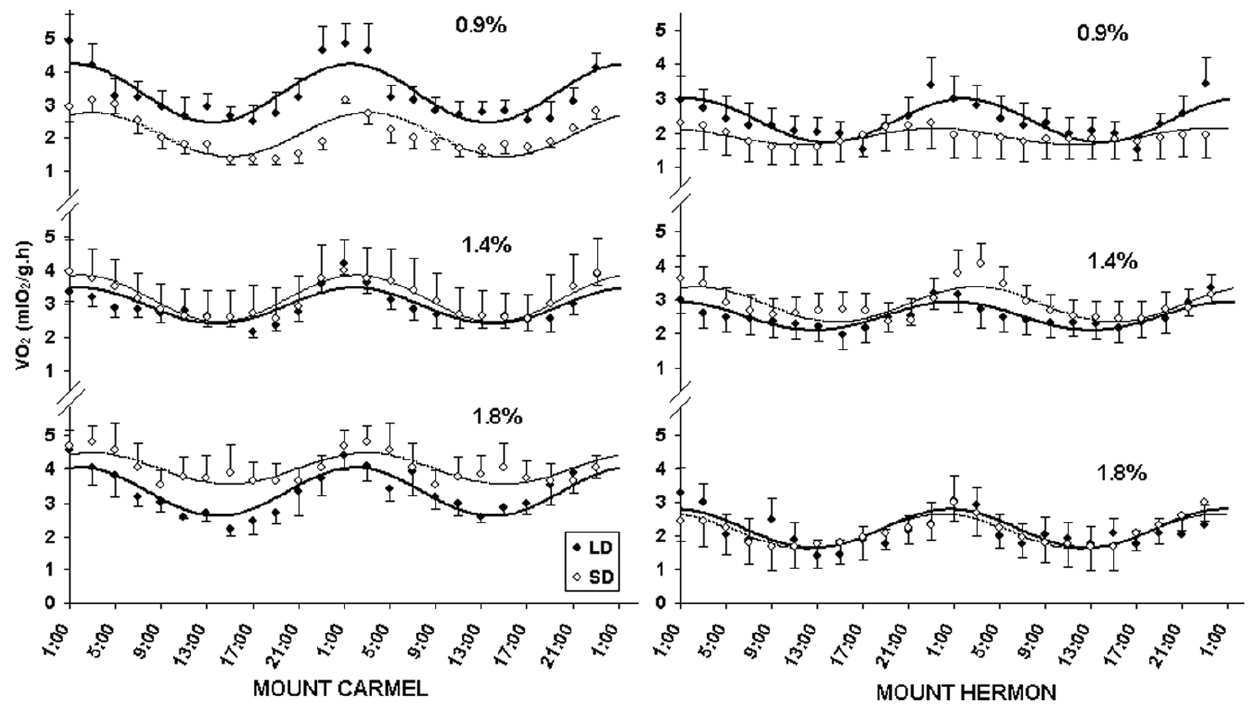
Figure 2. Oxygen consumption daily rhythms. Oxygen consumption ( VO 2 : mlO 2 /g.h) daily rhythms of short day ( SD: open circles, continuous line) and long day ( LD: closed circles, bold line) acclimated A. mystacinus at salinity regimes of 0.9, 1.4 and 1.8% from Mount Carmel and Mount Hermon. Curves denote best-fit cosine functions [54]. Error bars denote standard errors.